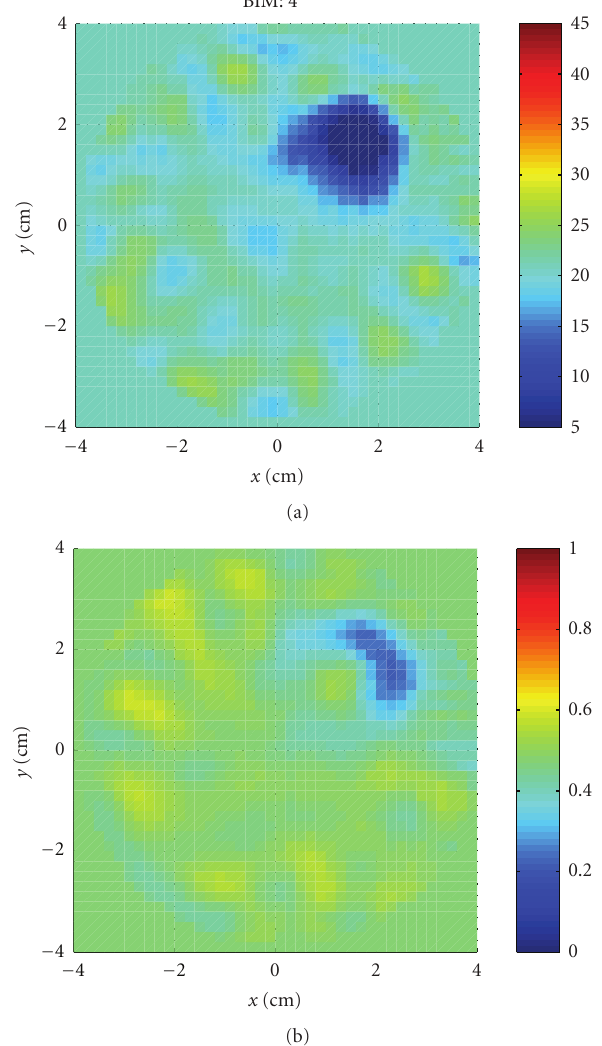
Figure 20: Reconstructions of the single acrylic sphere of Experiment 1 shown in Figure 19(a). (a): Relative permittivity. (b): Conductivity. The permittivity is recovered well but the shape in the conductivity is